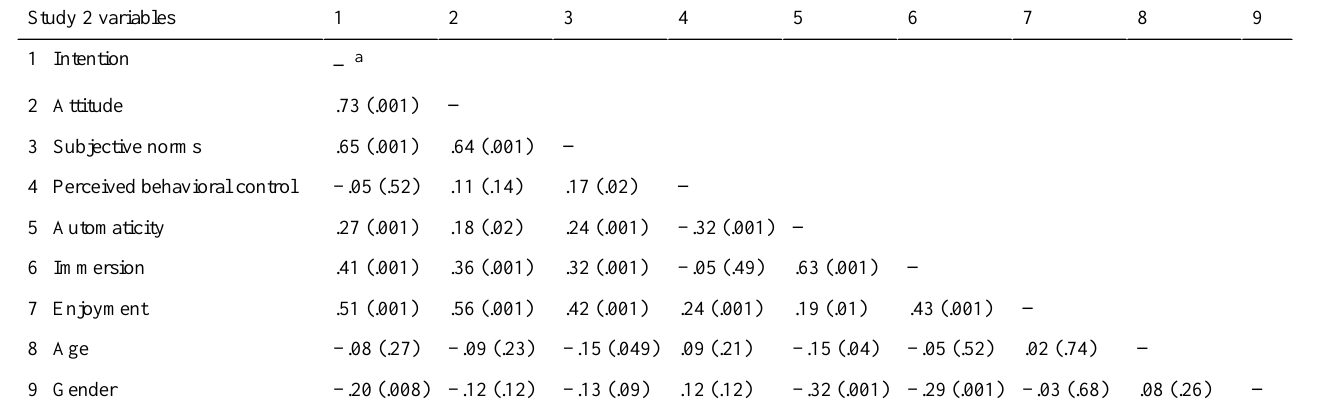
Table 4. Correlation matrix of variables in study 2 (N=179), shown as Pearson correlation coefficient r ( P